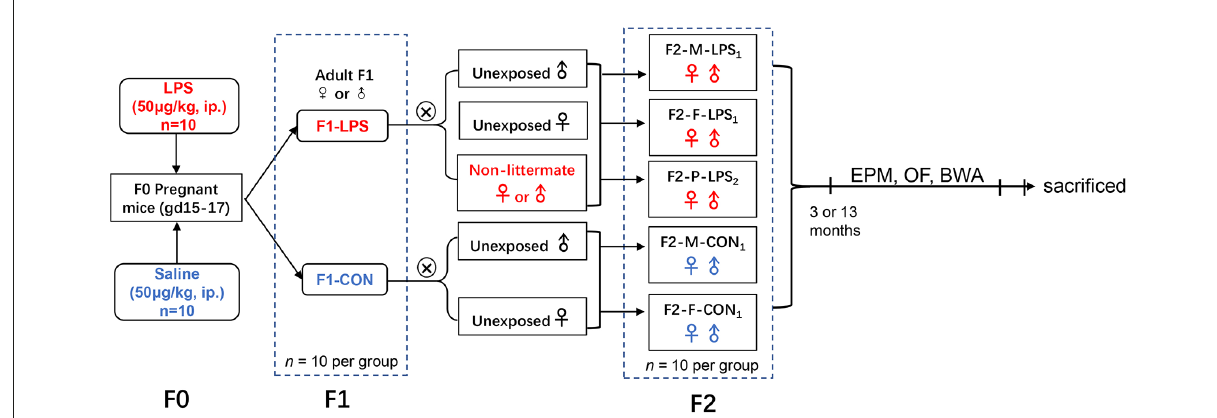
FIGURE1 Timeline of experimental events. F2-M-LPS 1 , mice whose mothers were exposed to prenatal inflammation; F2-F-LPS 1 , mice whose fathers were exposed to prenatal inflammation; F2-P-LPS 2 , mice whose parents were exposed to prenatal inflammation; F2-M-CON 1 , mice whose mothers were exposed to saline in utero ; F2-F-CON 1 , mice whose fathers were exposed to saline in utero ; EPM, elevated plus maze; OF, open field; BWA, black–white alley; LPS, lipopolysaccharide; i.p., intraperitoneal; gd, gestational